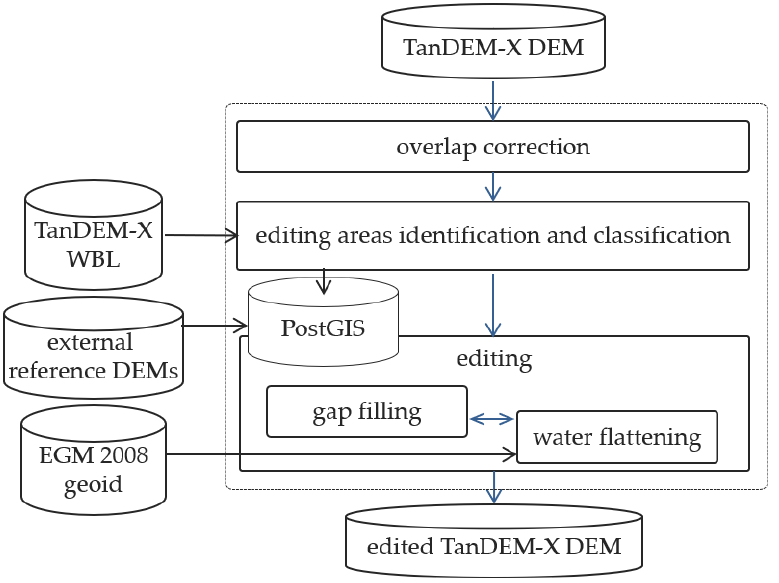
Figure 2. High-level flow chart of the developed automatic framework for DEM